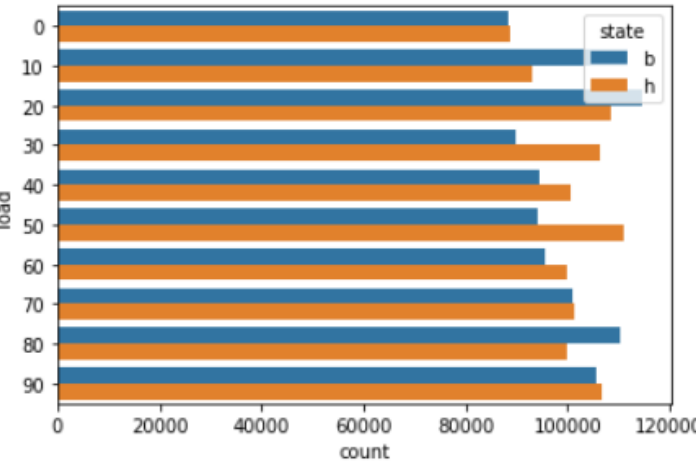
Figure 1. Total number of samples (healthy-condition h and broken-tooth condition b ) in the data